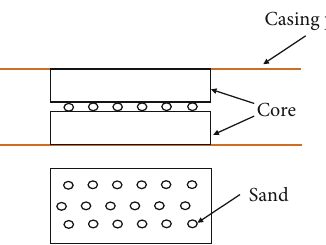
Figure 4: Spatial situation diagram of particle size distribution in the core.